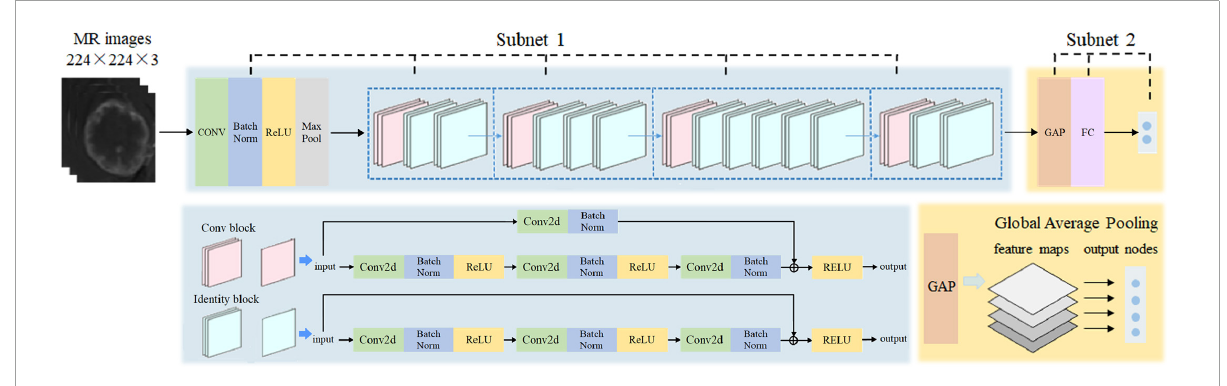
FIGURE1 Our deep learning network architecture: adding a global average pooling layer based on the residual